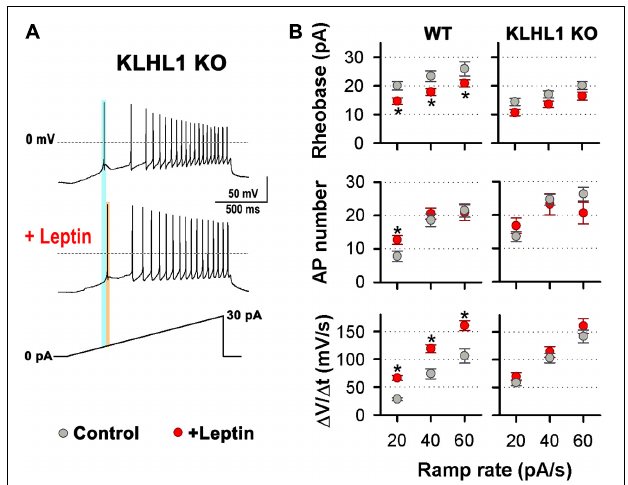
FIGURE 6 | Electrical Resistance to leptin in KLHL1 KO neurons. (A) Examples of neuronal firing elicited from V H = –75 mV by a 20 pA/s ramp in control and leptin-treated (100 nM) KLHL1-KO neurons. Light blue and orange lines indicate the rheobase before and after the addition of leptin, respectively. (B) Left: Rheobase (pA), number of action potentials and rate of membrane potential depolarization (Slope = (cid:49) V/ (cid:49) t , mV/s) in response to 20, 40 and 60 pA/s ramps in KLHL1 KO control ( n = 28, 28, 25) and leptin-treated ( n = 14, 14, 13) neurons. WT neuron behavior is shown for comparison (from Perissinotti et al., 2021). *Significantly different from control, P < 0.05, t -test.